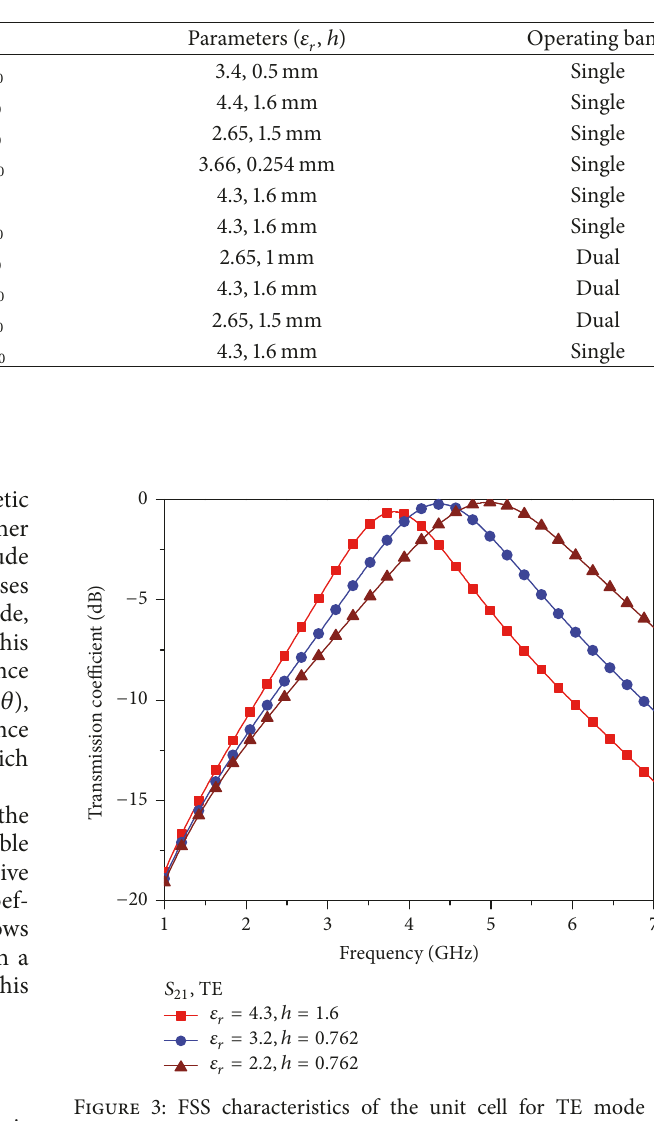
Table 1: Comparison of proposed FSS with other FSS in the literature.